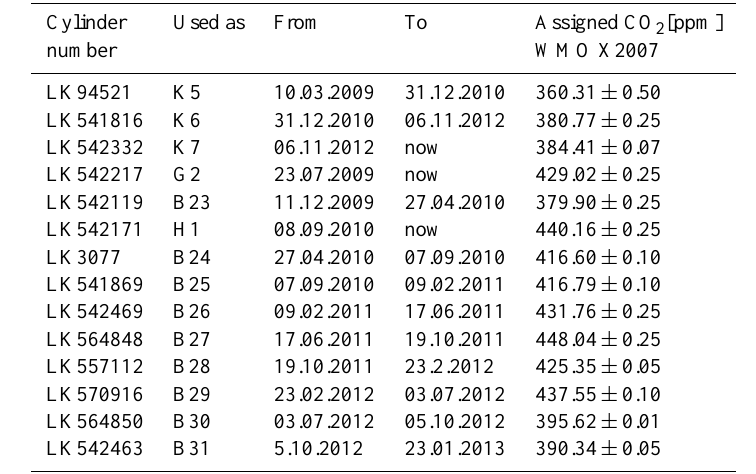
Table 2. List of calibration gas cylinders used by the NDIR system in the period from 2010 to 2012: K, G, H and B correspond to the usage as low span, high span, target and working gas, respectively. The gases were measured at the University of Bern and calibrated with a suite of NOAA standard cylinders. Cylinder Used as From To Assigned CO 2 [ppm] number WMO X2007 LK94521 K5